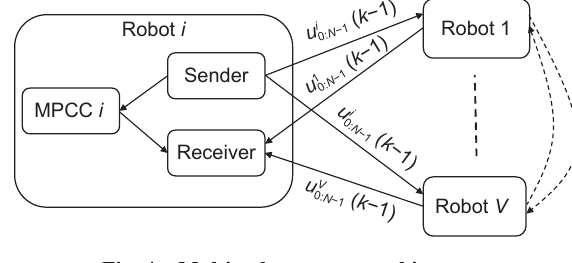
Fig. 4 Multi-robot system architecture. Algorithm 1 Proposed distributed MPCC algorithm for multi-robot motion